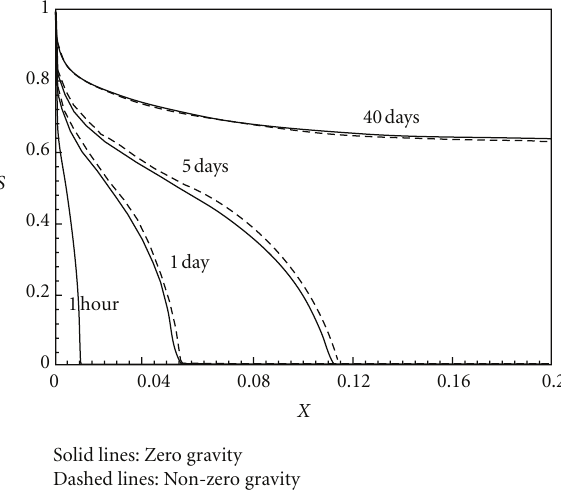
Color surface: water saturation